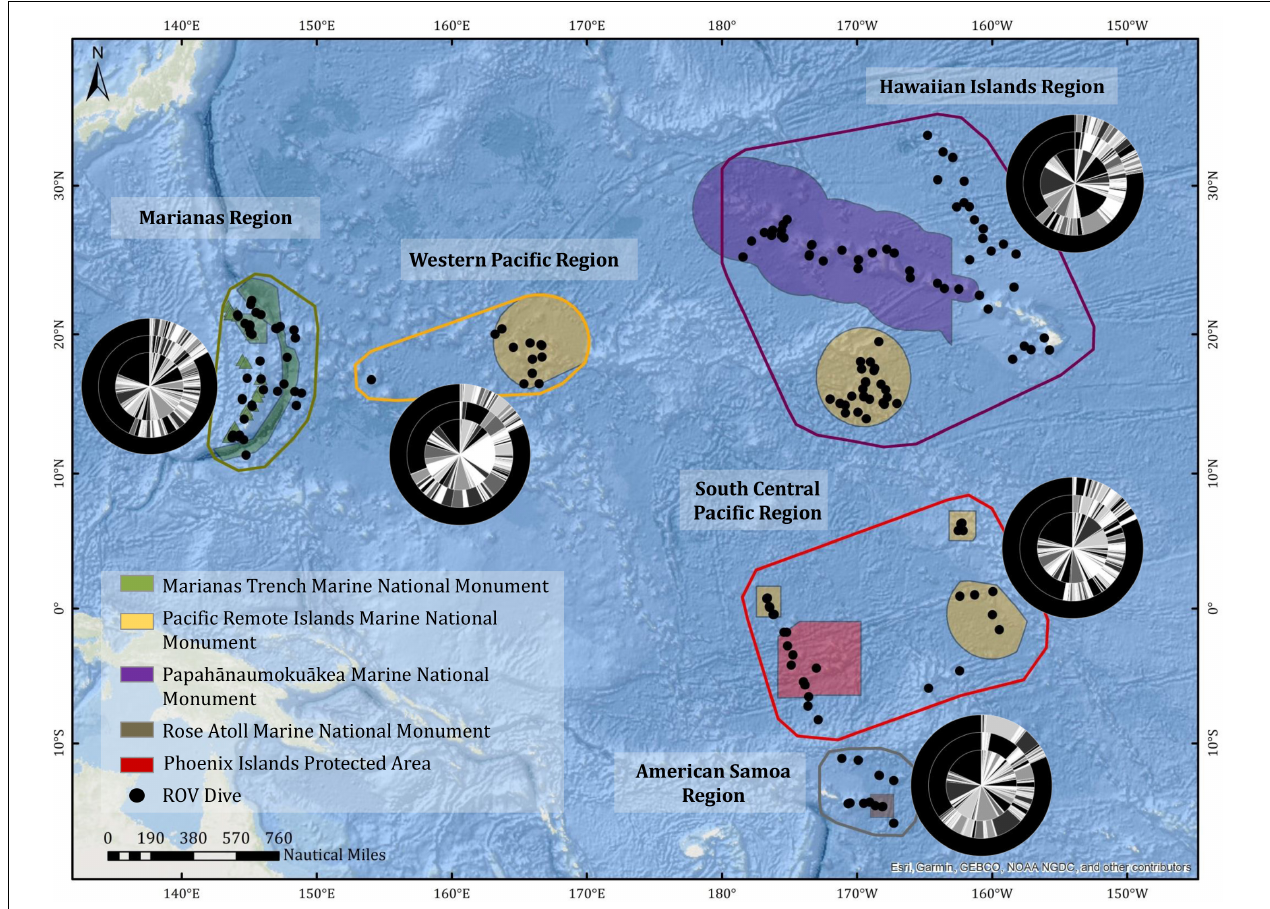
FIGURE 2 | CAPSTONE ROV dive sites (black dots) organized by region (Marianas, Western Pacific, Hawaiian Islands, South-Central Pacific, American Samoa). Marine Protected Areas boundaries are indicated by polygons. Nested pie charts show overall taxonomic diversity at the family level (inner circle), genus level (middle circle), and species level (outer circle), for each region. Unidentified annotations are always represented by the largest black bar originating at 12:00, progressing